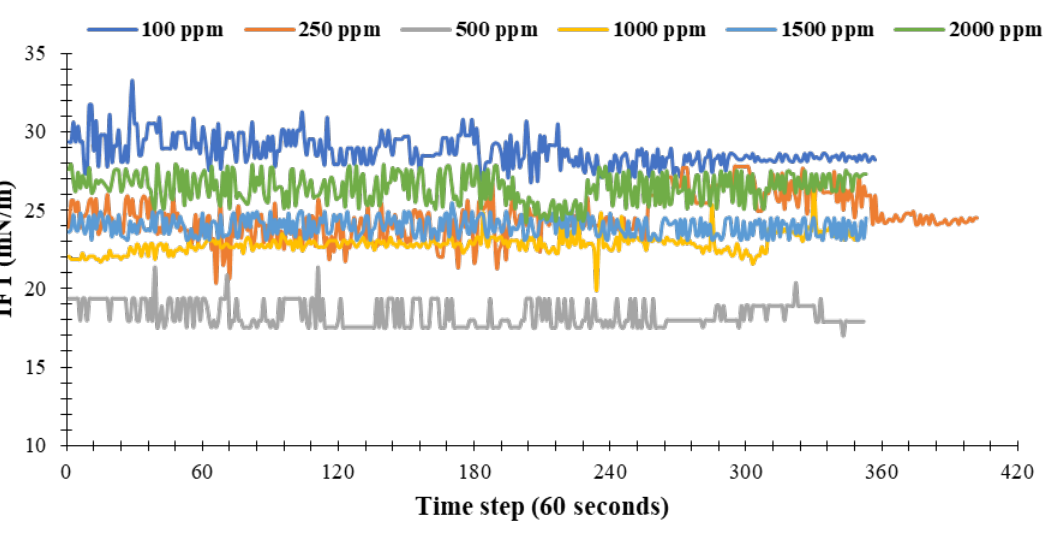
Figure 14. Dynamically measured water − oil interfacial tension over time at ambient pressure (14.7 psi) and temperature (25 °C).